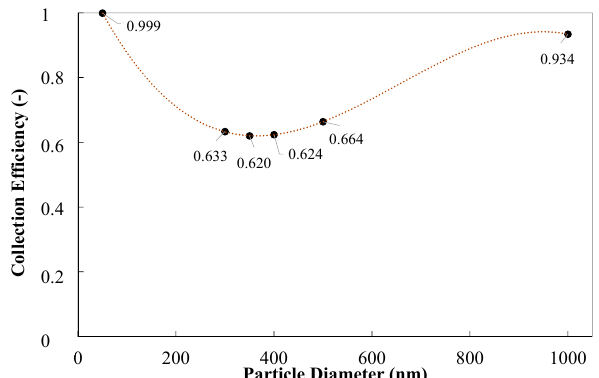
Figure 11. Filter e ffi ciency as function of soot particle diameter. Figure 11. Filter efficiency as function of soot particle diameter. Figure 11. Filter efficiency as function of soot particle diameter.